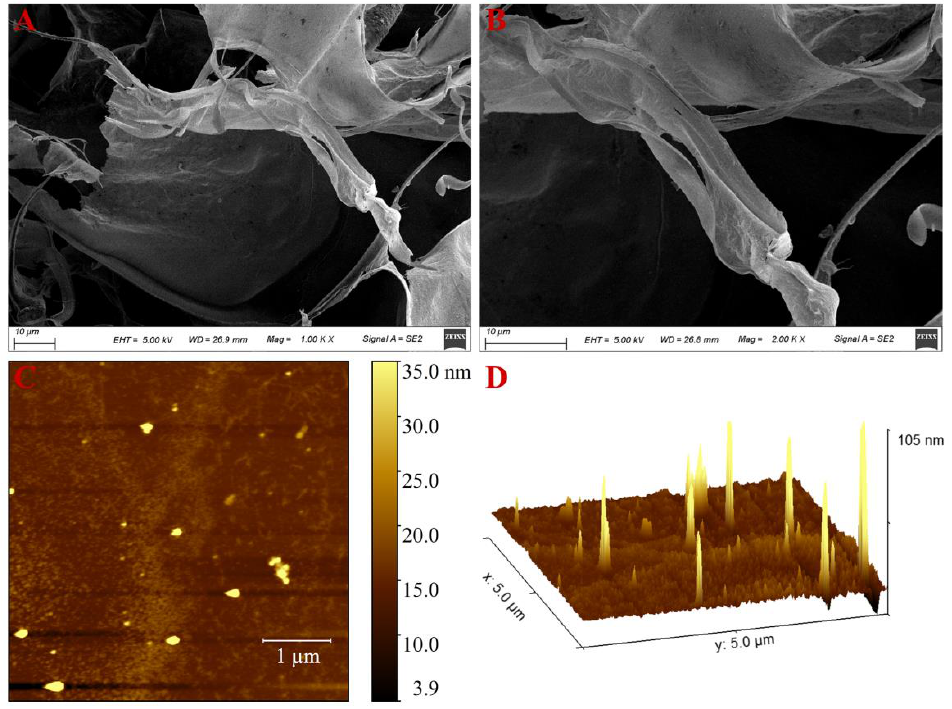
Figure 2. ( A ) 1000 × SEM images of LPP, ( B ) 2000 × SEM images of LPP, ( C ) planar AFM images of LPP, and ( D ) three-dimensional AFM images of LPP.